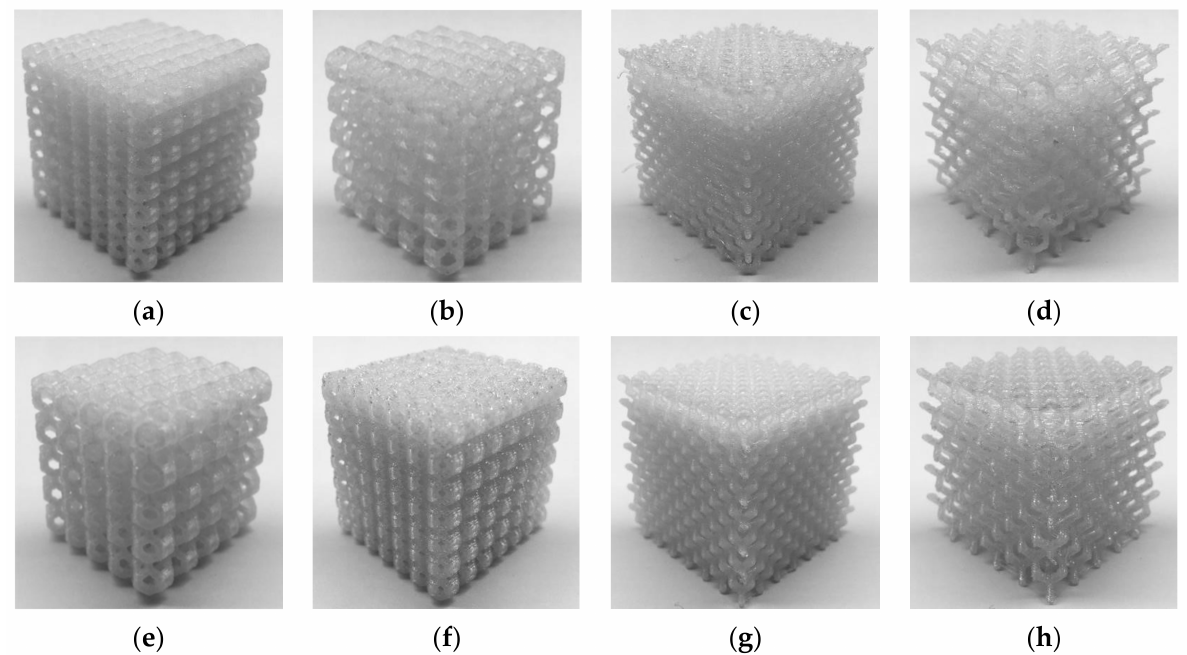
Figure 2. Polycarbonate (PC) printed specimens ( a ) 009; ( b ); 010; ( c ) 011; ( d ) 012; ( e ) 013; ( f ) 014; ( g ) 015; and ( h )